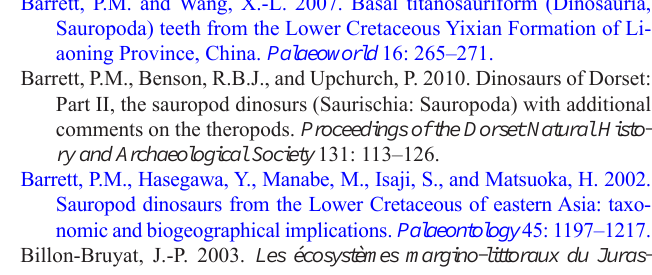
Fig. 3. Isolated teeth ( A , CHVm03.561; B , CHVm03.589) of an indeterminate embryonic or hatchling sauropod from the Berriasian (Early Cretaceous) of Cherves-de-Cognac, France; in labial (A 1 , B 1 ) and lingual (A 2 , B 2 ) views.